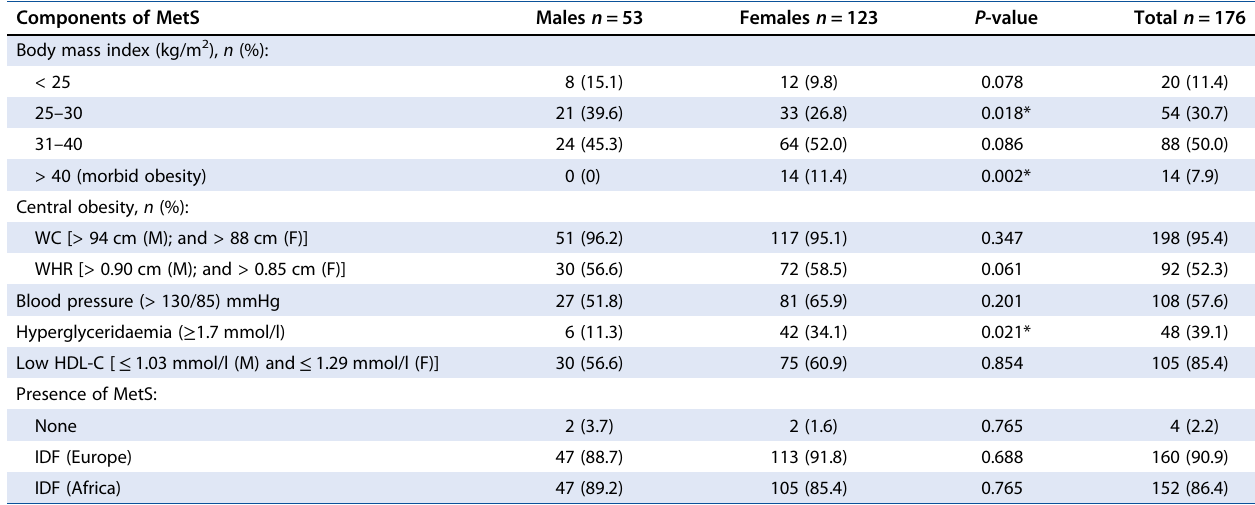
Table 3: Percentage frequencies of metabolic syndrome and its components among the study subjects stratified by gender Components of MetS Males n = 53 Females n = 123 P -value Total n =